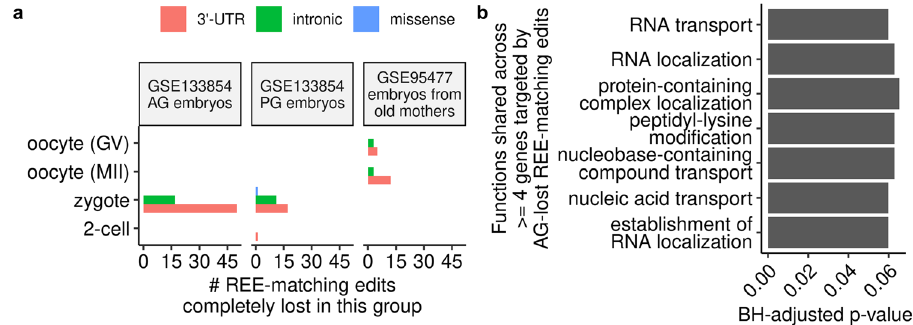
Fig. 4 Certain REE-matching edits could undergo organized loss in embryos with uniparental disomy and those from elder mothers. a Count of REE- matching edits that were completely lost in the abnormal uniparental disomy embryos (AG for androgenetic embryos and PG for parthenogenetic embryos) and embryos from elder mothers. See also Supplementary Figs. 23 – 25 for the sequence coverage of these edits in the pathological embryos/ embryos from elder mothers, and Supplementary Figs. 26 – 28 for their editing levels in normal samples. b Biological processes enriched by four or more genes targeted by AG-lost REE-matching edits. Only those with Benjamini – Hochberg-adjusted (BH-adjusted) p values less than 0.1 were